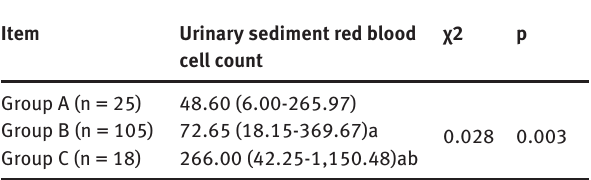
Table 3: Relationship between renal tubular injury and red blood cell count in urine sediment.